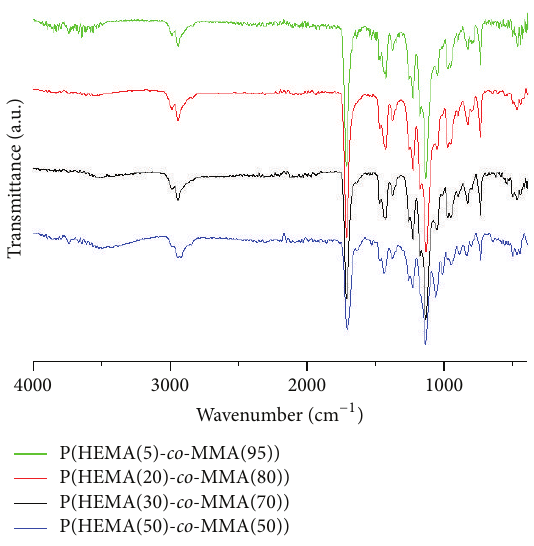
Figure 3: FT-IR spectra of P(HEMA- co -MMA)